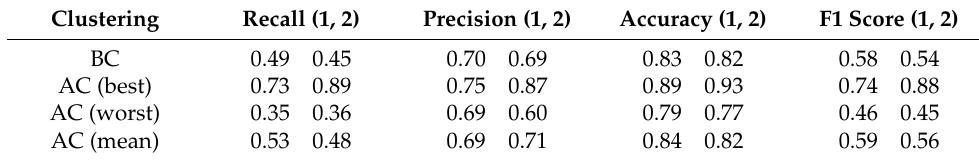
Table 3. Four performance results of GRU with training data type [Genre*ATV].